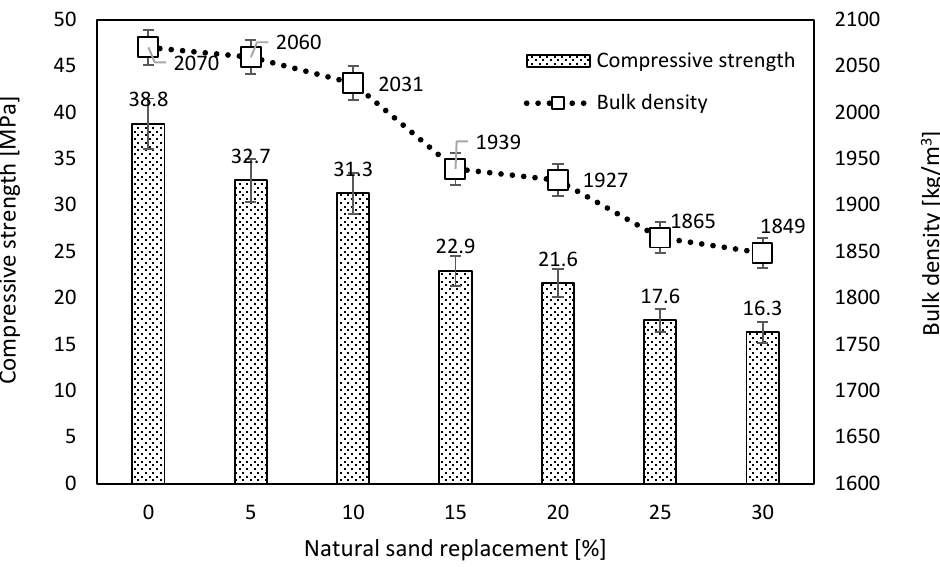
Figure 5. Compressive strength and bulk density after 28 days.